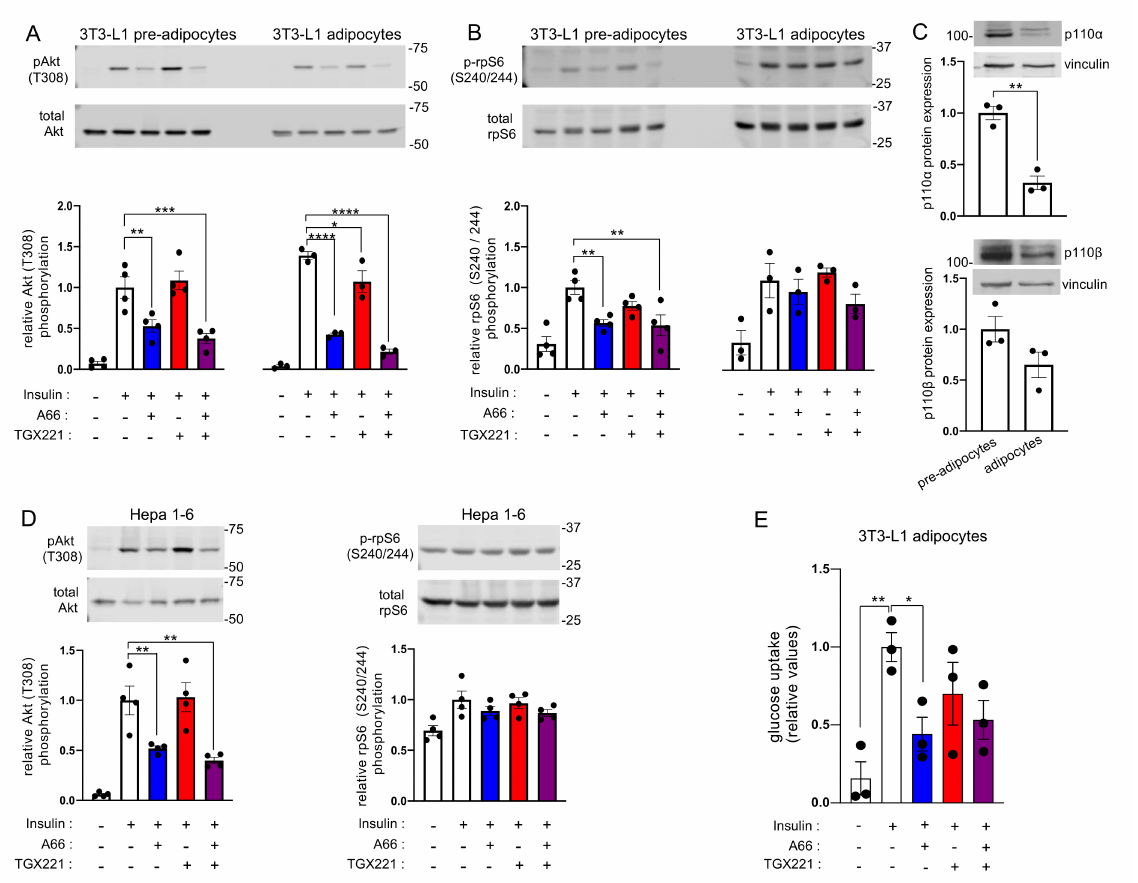
Figure 2. p110 α is the principal PI3K isoform engaged in insulin signalling in 3T3-L1 adipocytes and Hepa 1.6 cells. 3T3-L1 pre-adipocytes or differentiated adipocytes or murine Hepa 1.6 hepatocytes were treated with A66 (1 µ M, blue graph bars) or TGX221 (0.5 µ M, red graph bars) or a combination of both inhibitors (purple graph bars) followed by stimulation with 100 nM of insulin for 15 min at 37 ◦ C. ( A ) Levels of Akt (T308) phosphorylation in 3T3-L1 pre-adipocytes and adipocytes were determined by immunoblot analysis. Phosphorylation levels were normalised to total Akt levels detected in a second blot performed in parallel using the same lysates. ( B ) Ribosomal protein S6 (rpS6) phosphorylation (S240/244) was also detected in the same immunoblots. ( C ) The levels of expression of p110 α and p110 β in pre-adipocytes and differentiated 3T3-L1 adipocytes used for the signalling experiments were also determined by immunoblot analysis. ( D ) Akt (T308) and rpS6 (S240/244) phosphorylation in Hepa 1-6 murine hepatoma cells treated and stimulated as above. Representative immunoblots and bar graphs with pooled data from three or four ( n = 3–4) independent experiments are shown. Data are presented as mean ± SEM. ( E ) Insulin-stimulated glucose uptake in 3T3-L1 adipocytes treated with inhibitors as above. Data from three ( n = 3) independent experiments are shown. Statistical analysis was performed by one-way ANOVA with Dunnett’s multiple comparisons test between insulin-stimulated vehicle-treated and insulin-stimulated inhibitor-treated samples ( A , B , D , E ) or by unpaired two-tailed t -test ( C ). * p < 0.05; ** p < 0.01; *** p < 0.001; **** p <